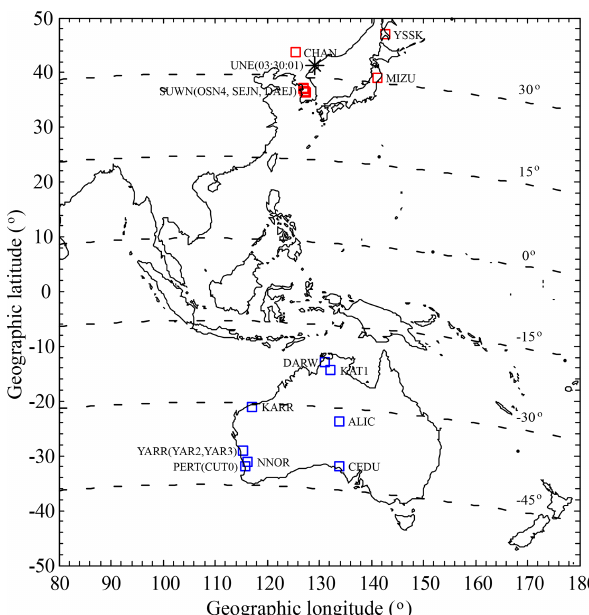
Figure 1. The positions of UNE and IGS stations. The position of 3 September 2017 North Korean UNE is represented by a black star. The locations of IGS stations in both hemispheres are represented by red and blue squares. Lines of constant geomagnetic latitude are represented by black dashed lines.